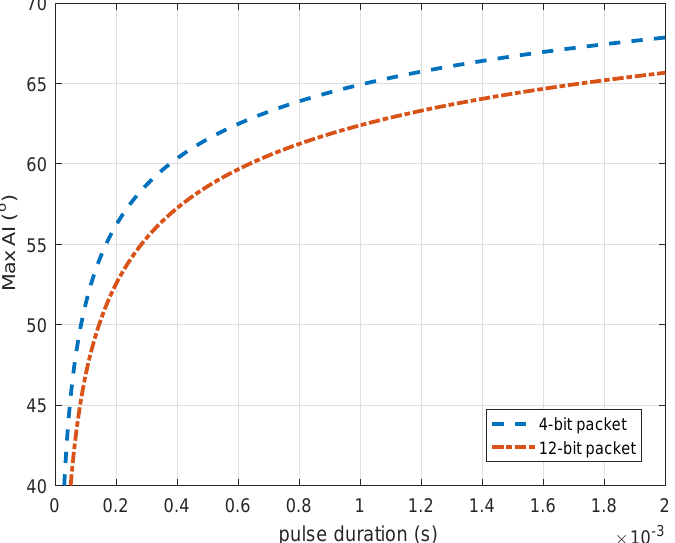
Figure 11. Maximum angle of incidence (Max AI) for encoding pulse duration between 0 and 2